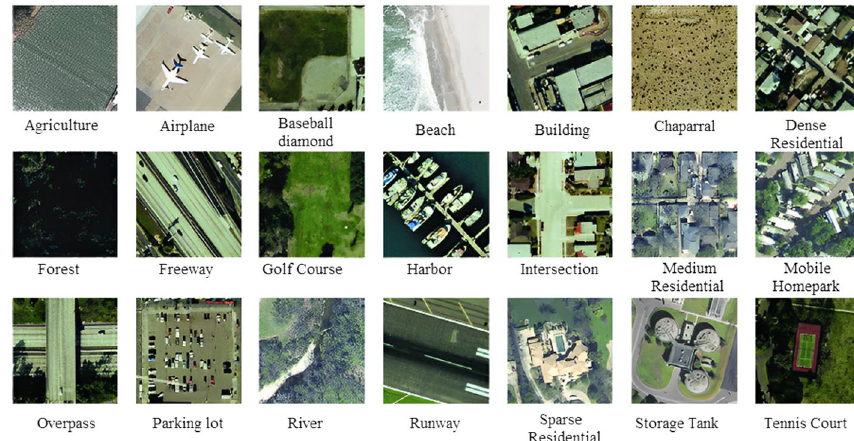
Fig. 5 Samples of UCM dataset